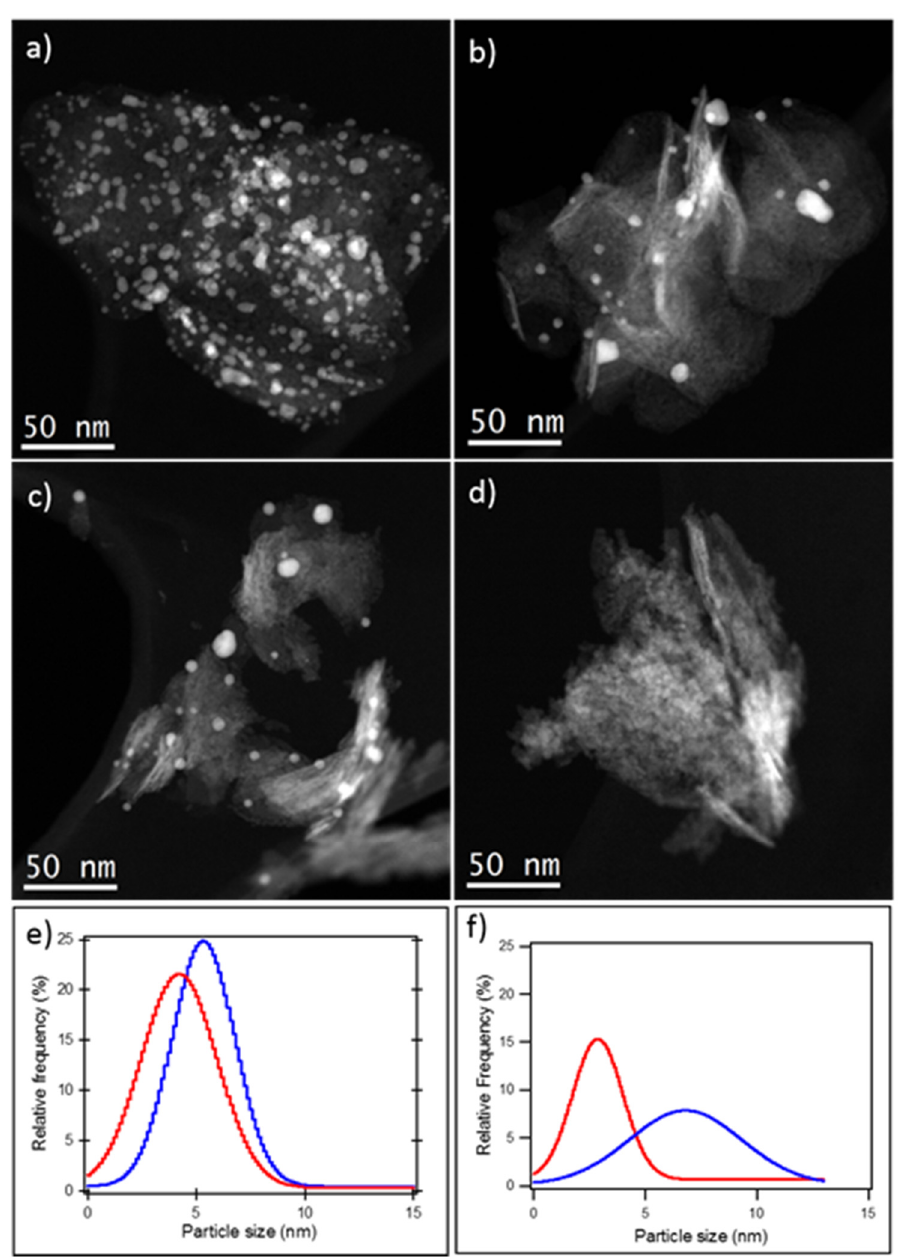
Figure 2. Low magnification HAADF-STEM images of fresh ( a ) Au SI /NiO and ( b ) Au DP /NiO versus ( c ) Au SI /NiO and ( d ) Au DP /NiO, after reaction. Comparison of the Gaussian fit to the respective particle sizes determined from TEM images of the fresh catalyst (red), and after reaction (blue); Au SI /NiO in ( e ) and Au DP /NiO in ( f ).